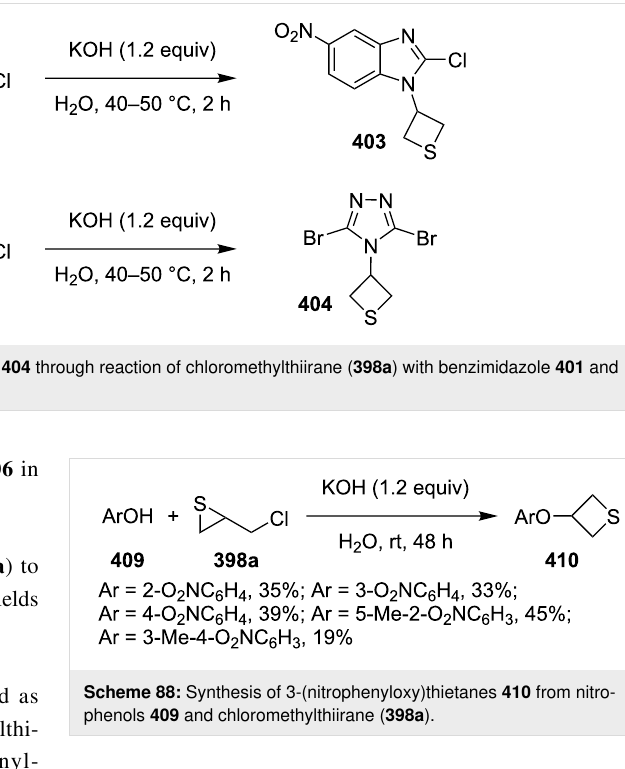
corresponding N -aryl- N -(thietane-3-yl)cyanamides 412 in mod- erate to good yields [113] (Scheme